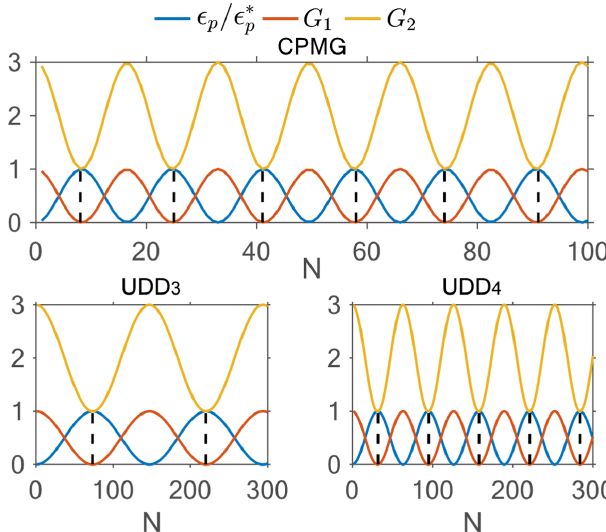
= ϵ (cid:3) FIG. 3. Scaled entangling power ( ϵ , blue line) and Makhlin p p invariants ( G 1 , red lines; G 2 , yellow lines) as a function of the number of repetitions of the CPMG (top) and UDD 3 or UDD 4 (bottom) units for a single nuclear spin. The dotted lines corre- spond to the analytically expected minima of G 1 (see the text). We consider the k ¼ 1 resonance for each sequence. The times for the UDD sequences are optimized around the analytical resonance n 3 . 1811 ; 3 . 1852 ; 3 . 1862 Þ μ s]. For ; t ; t time [ ð t CPMG UDD 3 UDD 4 Þ ¼ ð 2 π · ð 60 ; 30 ; 314 Þ kHz, the nuclear spin, we set ð A; B; ω L Þ ¼ 2 = 9 and for the electron ’ s spin projections s 0 ¼ − s 1 ¼ 1 = 2 . ϵ (cid:3) p ¼ is the maximum value the entangling power can